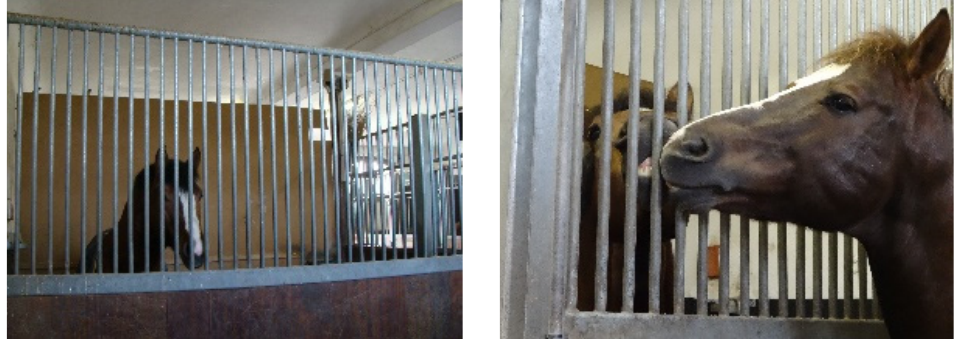
Figure 1. “Conventional box” stabling (CB) allows only restricted tactile contact.